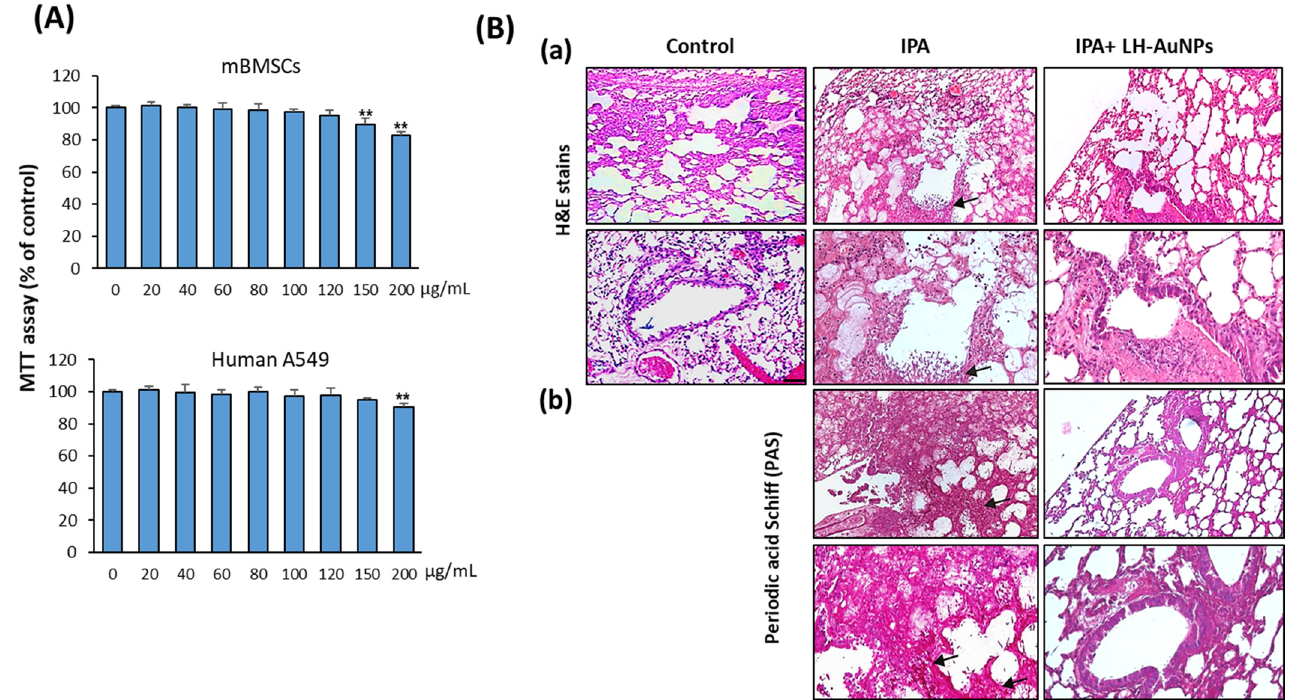
Figure 5. LH-AuNPs repair lung tissue damage in IPA mice. ( A ) Cytotoxicity of LH-AuNPs on human lung cancer cell line, A549, and primary mBMSCs. The dose-dependent effect of LH-AuNPs on cell viability was measured by MTT assay after 48h of treatment. Values are mean ± SD of three independent experiments (** p < 0.005, compared to control non-treated cells). ( B ) Histological analysis of lung tissues (3 days post-LH-AuNPs treatment) from control, IPA-non-treated, and IPA- treated mice with LH-AuNPs. Sections stained with H&E ( a ) and periodic acid–Schiff (PAS) ( b ). Extensive fungal growth and tissue damage are evident in the non-treated IPA mice. Arrows indicate fungal balls with great density fungi and proliferating hyphae, while there is a lack of fungal balls and hyphae in the lungs of animals with LH-AuNPs treatment.